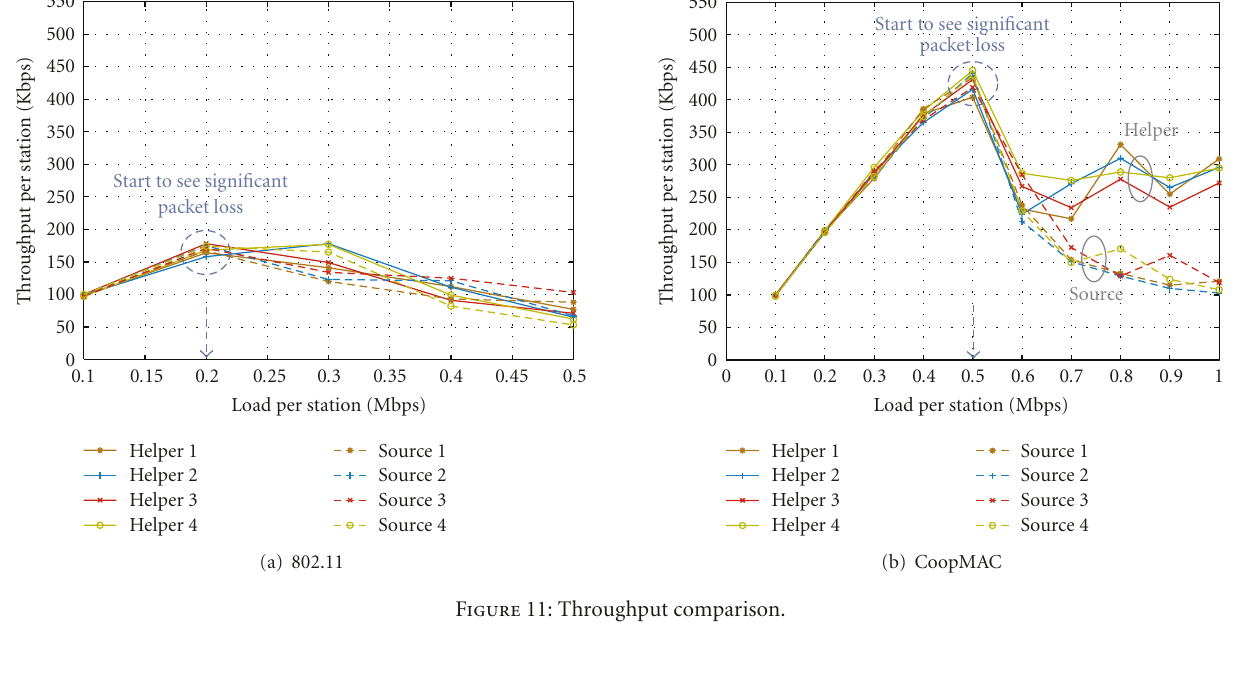
Table 8: Settings for study of network capacity and